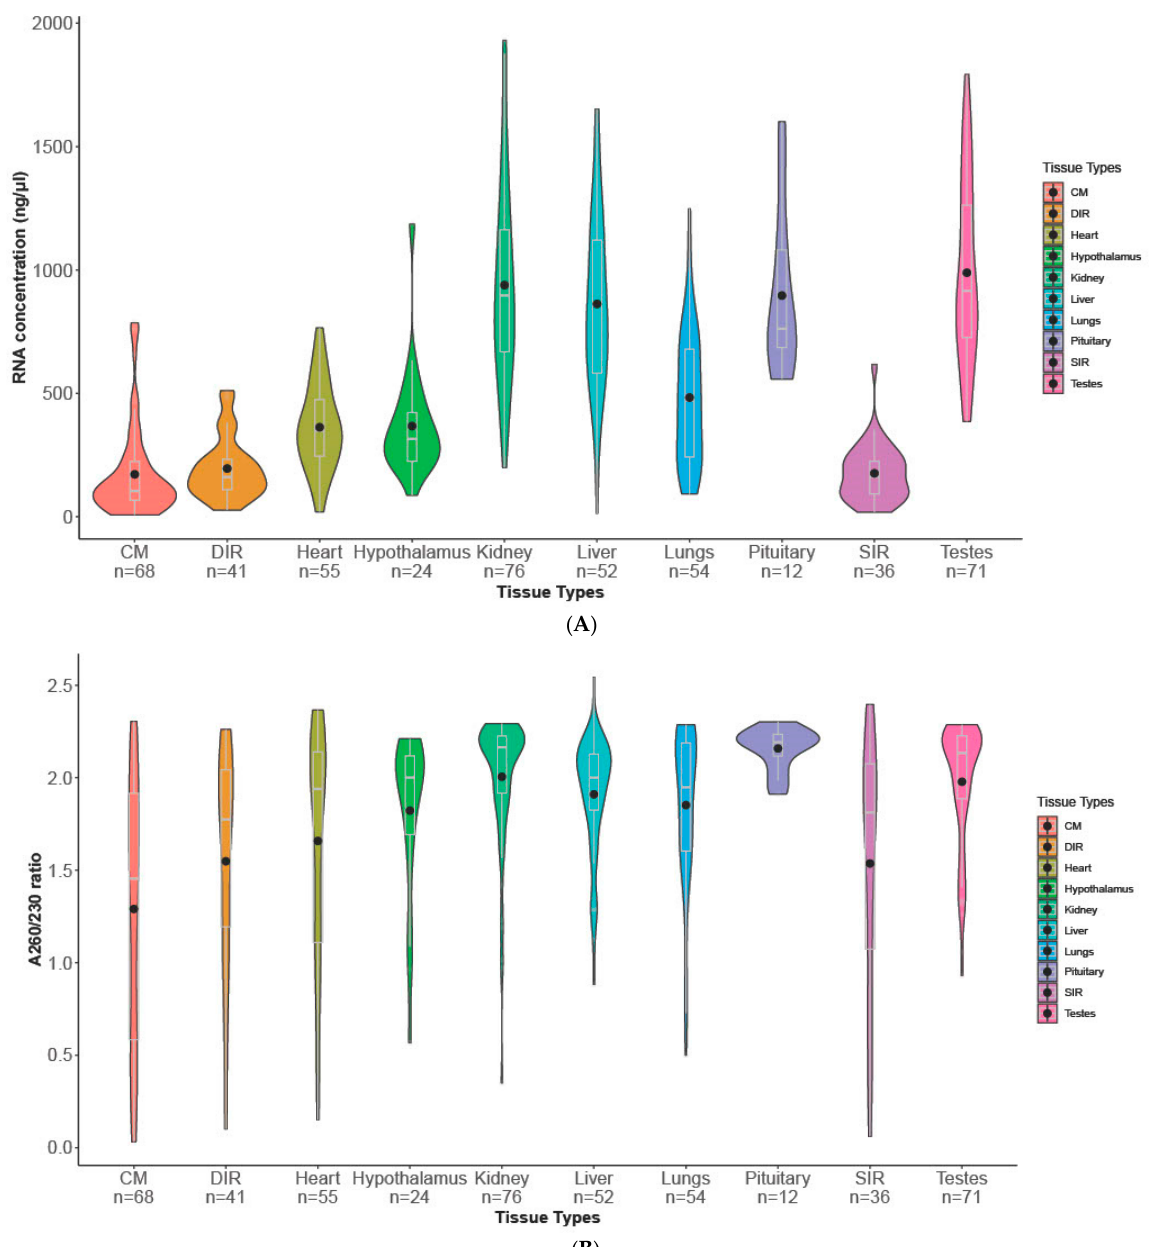
Figure 1. ( A ) RNA concentrations from the ten different tissue types are plotted. Kidney, liver, pituitary and testis have higher average RNA concentrations in comparison with cremaster muscle, inguinal rings, heart and hypothalamus. CM: cremaster muscle; DIR: deep inguinal ring; SIR: superficial inguinal ring. ( B ) RNA quality estimated using the A260/230 ratio from the ten different tissue types are plotted. Cremaster muscle had the lowest average value with a mean of less than 1.5, followed by inguinal rings (DIR and SIR). CM: cremaster muscle; DIR: deep inguinal ring; SIR: superficial inguinal ring.